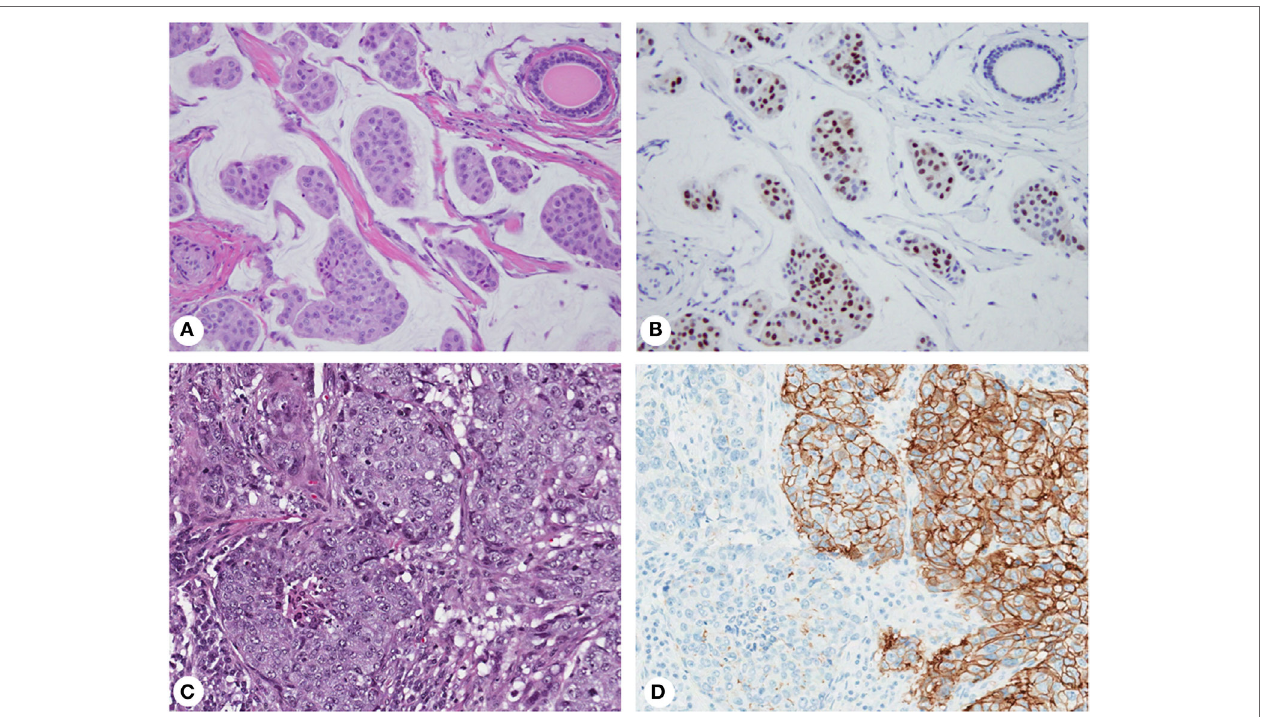
FiGURe 2 | Biomarker heterogeneity of breast cancer: mucinous carcinoma (A) with variable expression of estrogen receptor from no immunoreactivity to nuclear staining with weak to strong intensity (B) ; invasive ductal carcinoma (C) with areas of 3 + (positive) and 1 + (negative) membranous staining for human epidermal growth factor receptor 2 (D) . Magnification: 200 × (A–D) ; hematoxylin-eosin staining (A,C) and immunohistochemistry (B,D)